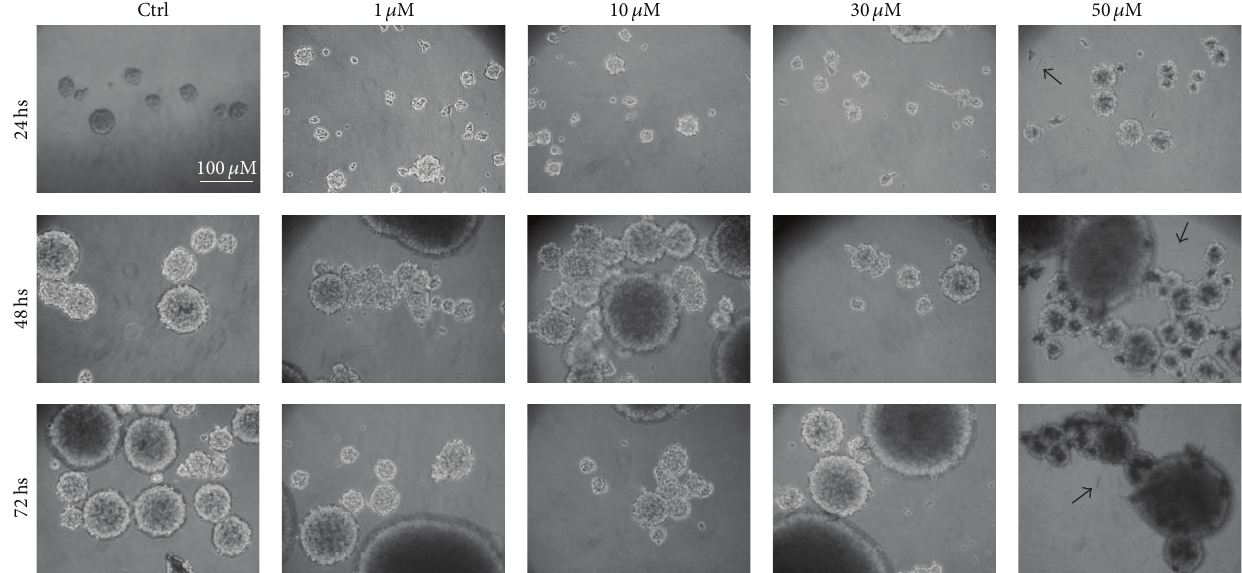
Figure 4: Representative images of GSC morphology after treatment with increasing concentrations of Pio for24, 48, and 72 hs. Generally, Pio did not induce any relevant morphological change. Images of G144 cells show that GSCs still grow as neurospheres in nonadherent conditions after drug exposure. Black arrows indicate insoluble threadlike precipitates, which can also be observed on the cell surfaces.